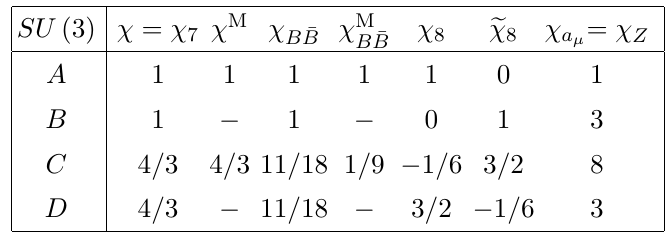
Table 1 . Table of the SU(2)-factors entering the Wilson coe(cid:14)cients for the various processes. Results are given for the six representations I-VI de(cid:12)ned in eq. (2.4).